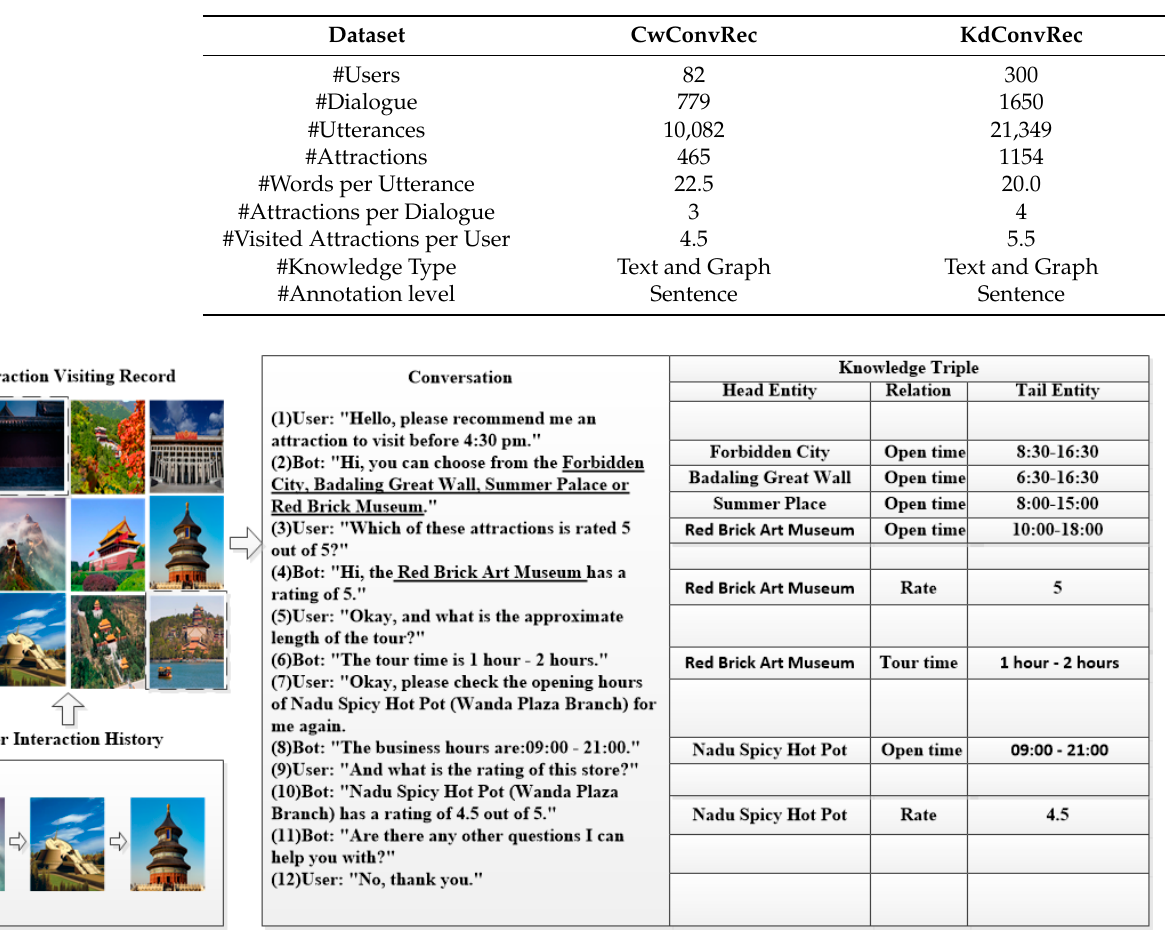
Figure 4. An illustrative example from the CwConvRec dataset. We selected three attractions (boxed by the dashed line) sharing the same category in the user interaction history from the visiting record that corresponded to the attractions (marked by underline) recommended by the conversation. The rightmost section shows the corresponding knowledge triplets.